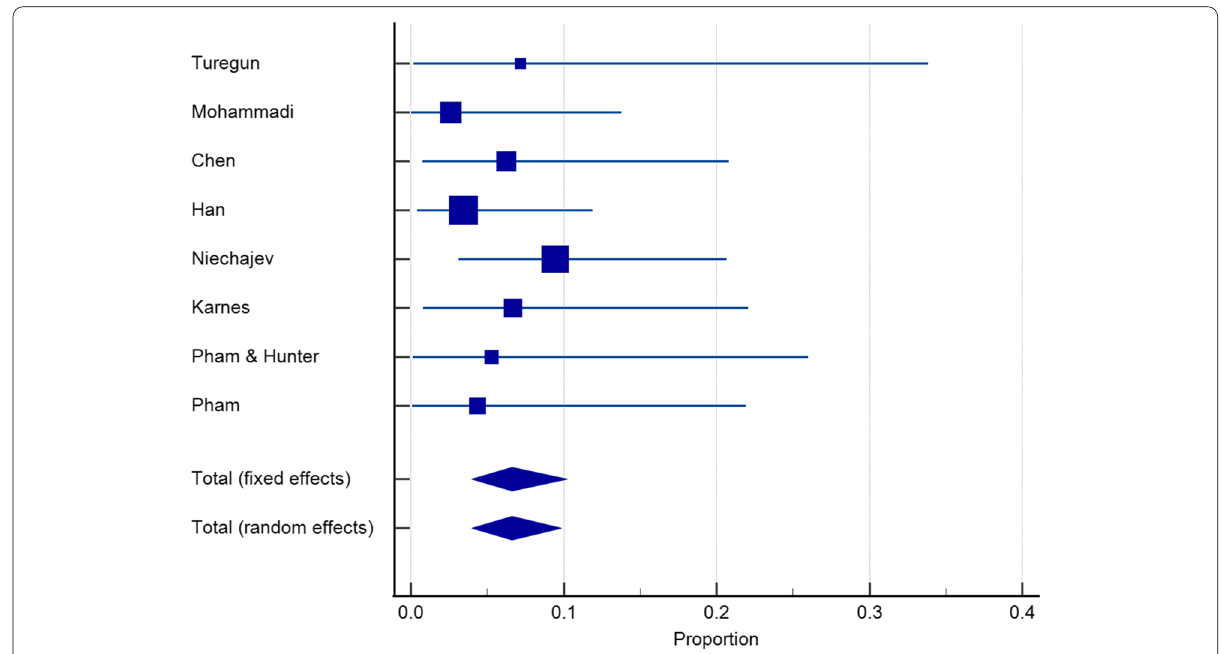
Fig. 9 Revision rates reported for Medpore in both fixed and random-effects model